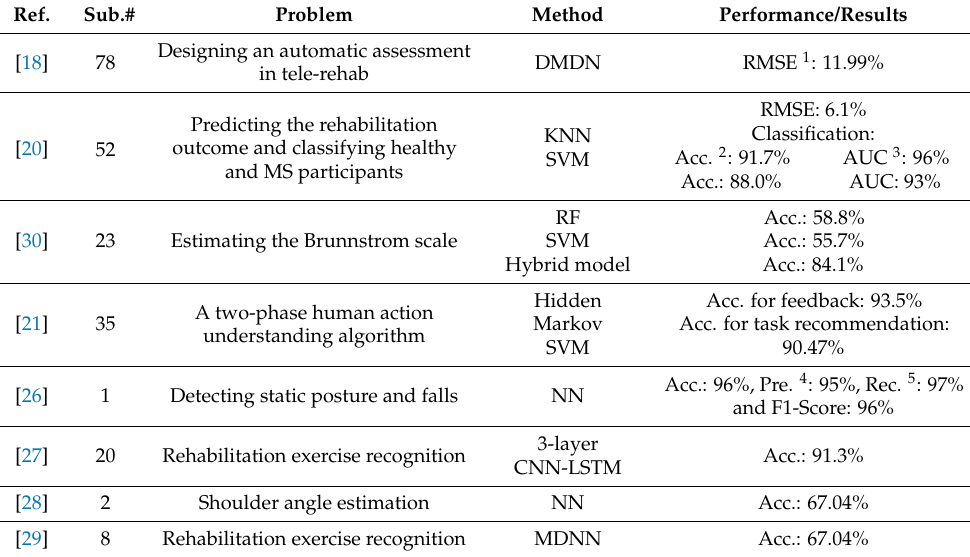
Table 1. Summary of vision-based approaches reviewed in this study.